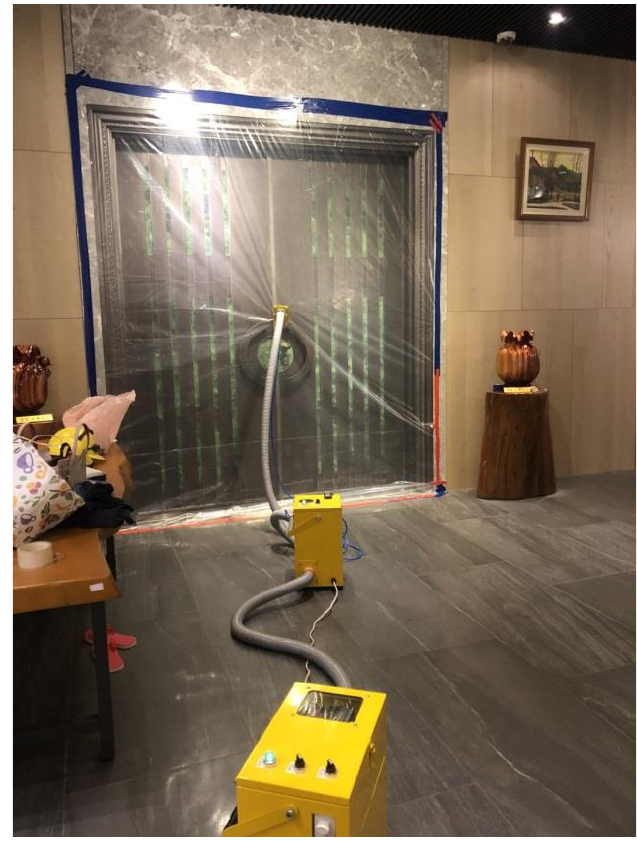
Figure 3. Field test images.